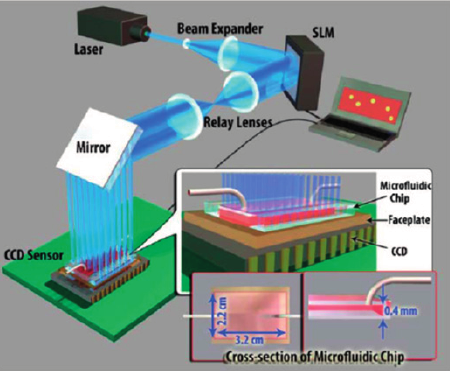
Figure 14. Schematic image of high-throughput on-chip fluorescent detection platform. CCD, structured illumination array is integrated together for generating image of fluorescent sample in microfluidic chip size of ~22 × 32 × 0.4 mm. This could capture 144 lensfree images within 36s (Reproduced with permission from [37]).